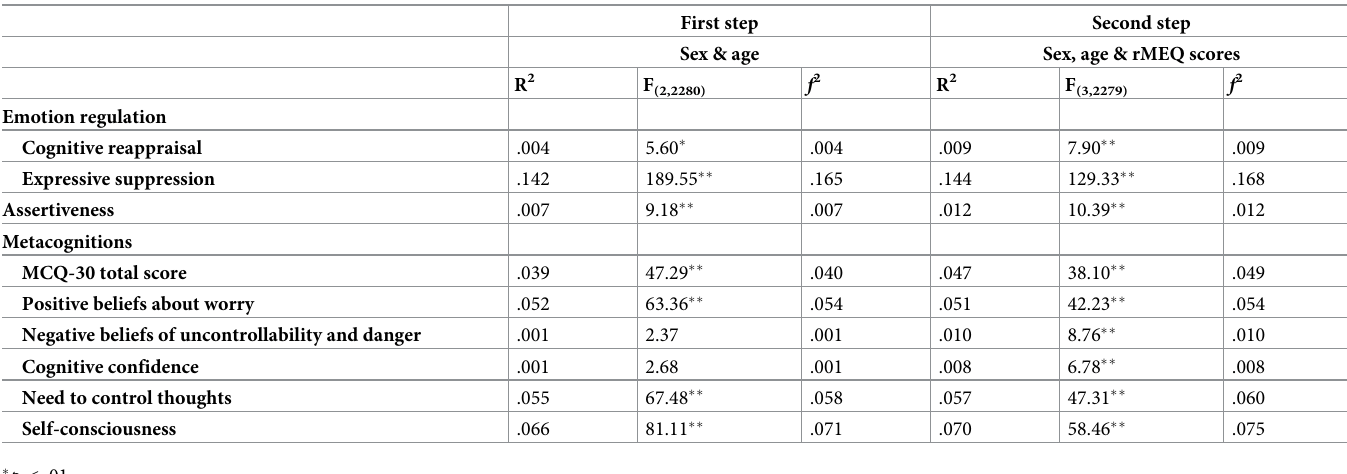
Table 3. Results of stepwise multiple regression analyses.